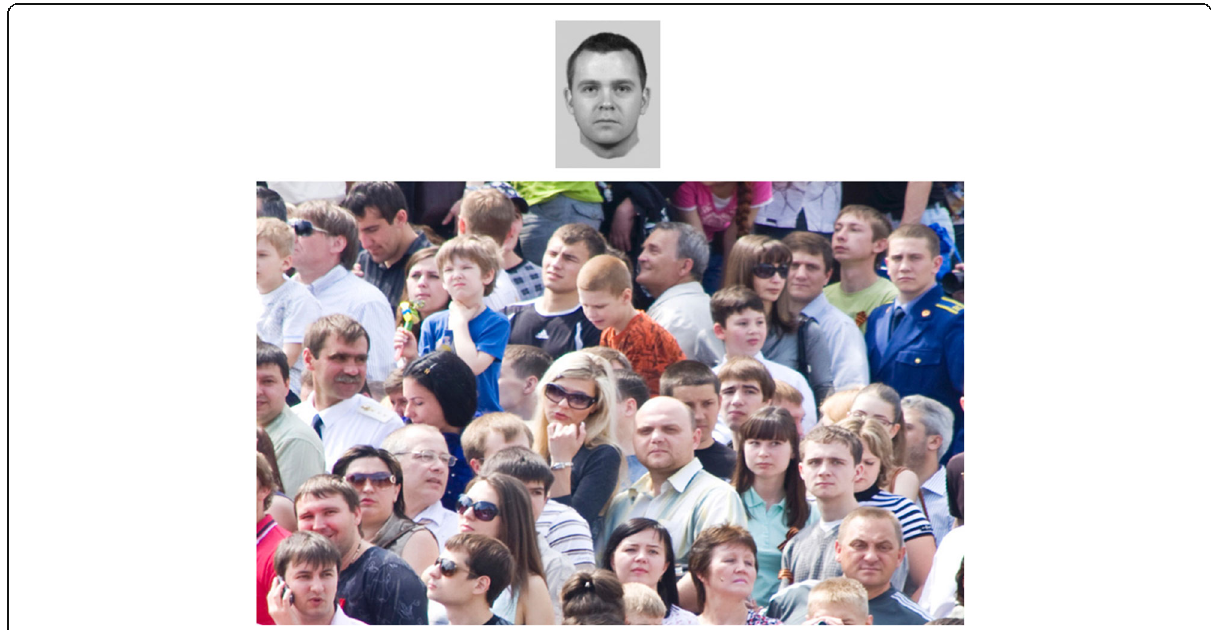
Fig. 3 A sample target-present trial from the Crowds